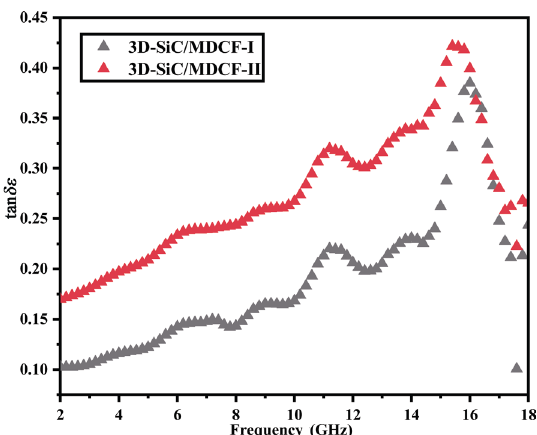
Fig. 7 Dielectric loss tangents of 3D-SiC/MDCF-I-wax and 3D-SiC/MDCF-II-wax